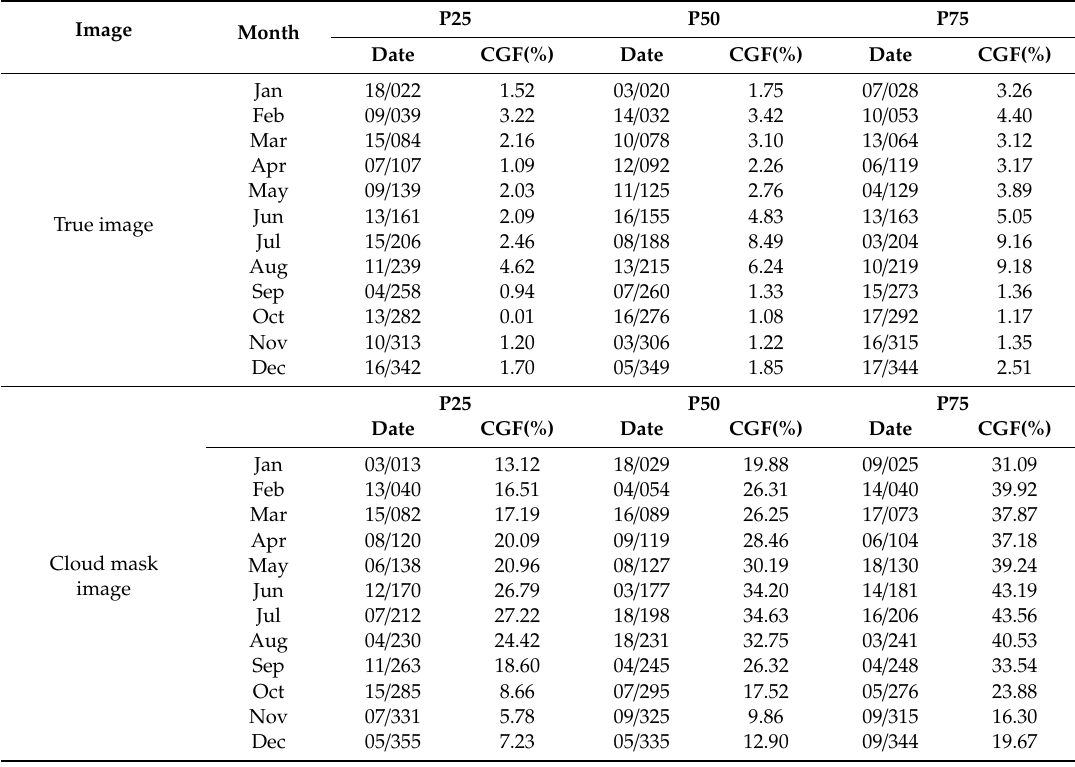
Figure 6. Empirical cumulative distribution function (ECDF) of the multi-year average cloud-gap fraction for each month in the 3DTF product from 2003 to 2018. As an example, the purple, pink, and yellow boxes represent the cloud-gap fraction under the P25, P50, and P75 conditions, respectively for October. Thus, the images with a cloud-gap fraction closest to 9.2% (purple box), 17.5% (pink box), and 24.1% (yellow box) were selected as the October cloud mask. Table 1. Information regarding the true and cloud mask images used in this study.